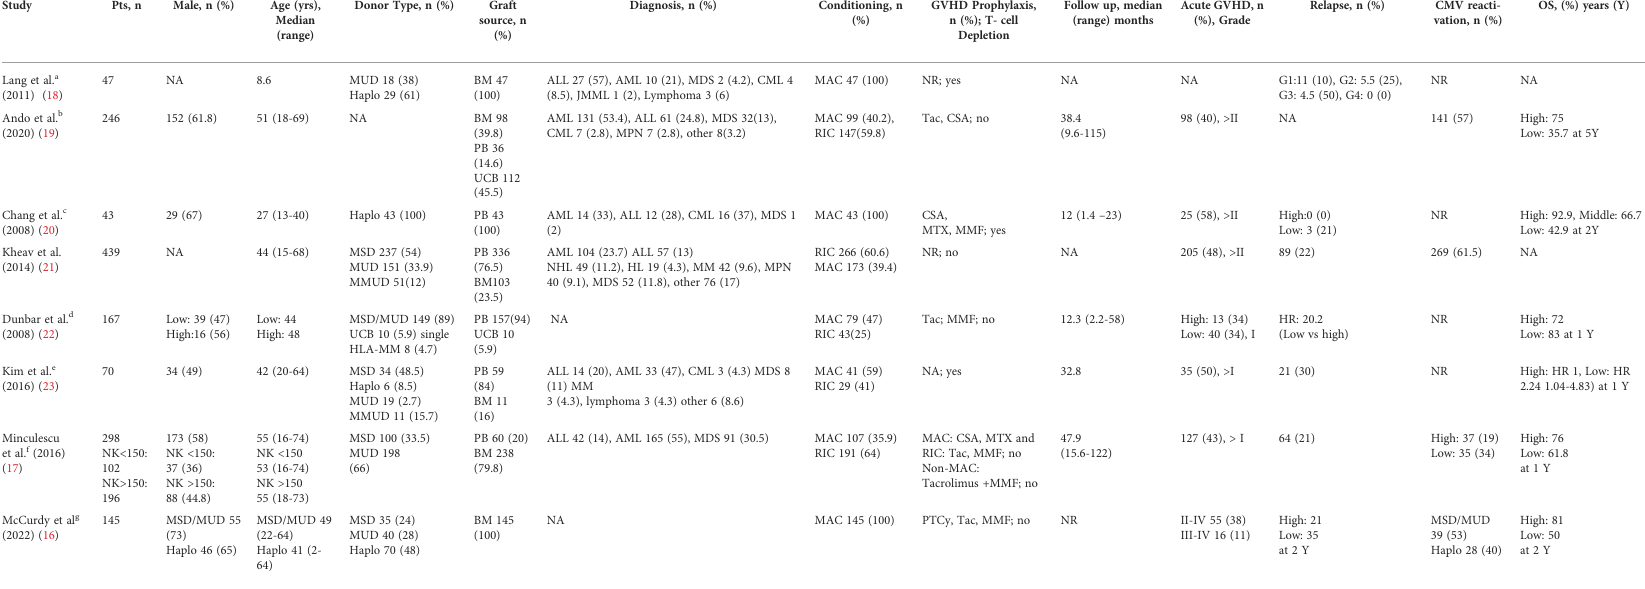
TABLE 1 Impact of NK cells reconstitution on outcomes after allogeneic HSCT. Study